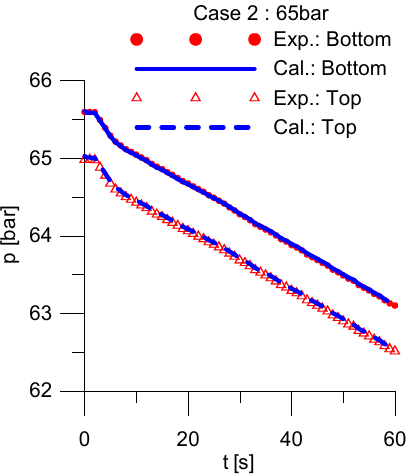
Figure 16. Evolution of the cross-section averaged absolute pressure at the top and bottom of the test section (Case 2).